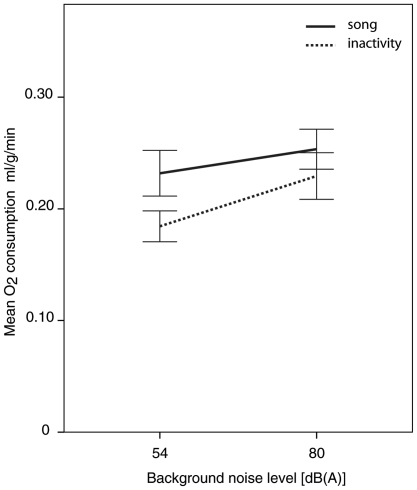
Mean  during song (solid line) and during inactive periods (dashed line) for all three birds at lowest and highest background noise conditions.Error bars ±1 s.e.m.